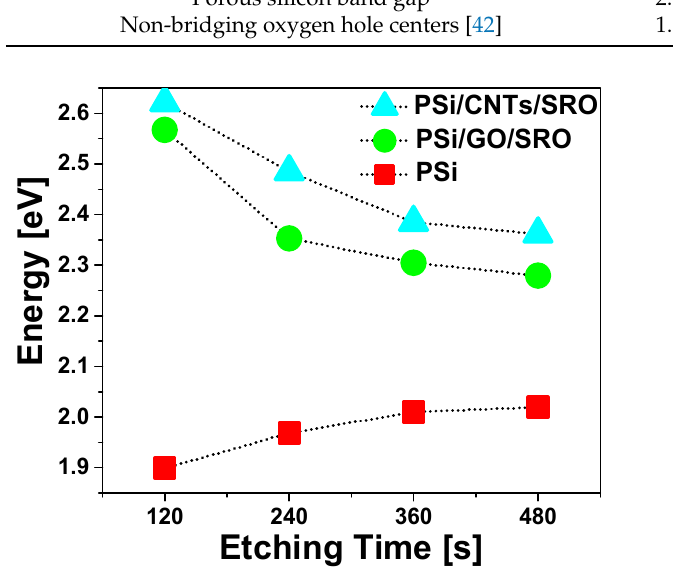
Figure 9. PL shift peaks of PSi layers, Si-n/PSi/CNTs/SRO and Si-n/PSi/GO/SRO structures. Blue emission (2.8 eV) exhibited in the Si-n/PSi/CNTs/SRO structures has already been observed in diamond fi lms and it is a tt ributed to luminescent centers present in the CNTs [40]. The green emission (2.5 eV) is due to nitrogen contamination; N-bonded car-